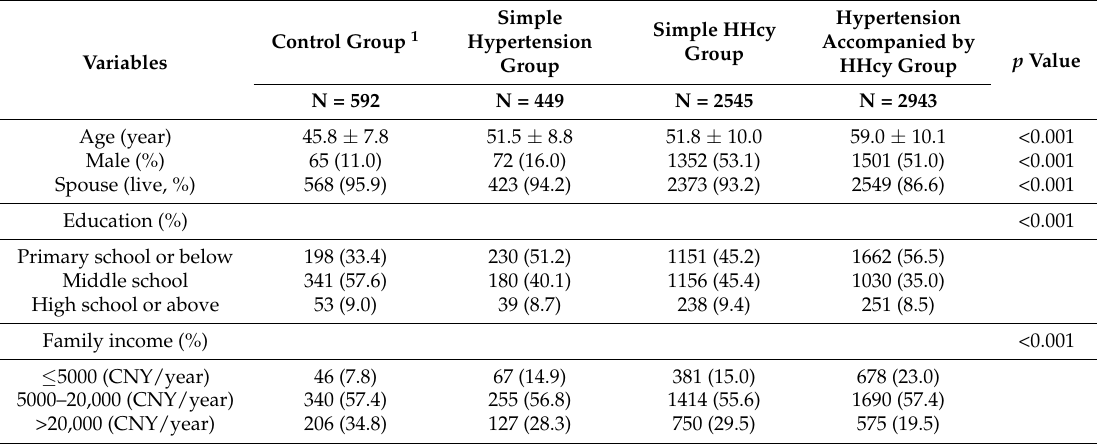
Table 1. Baseline characteristics of the study